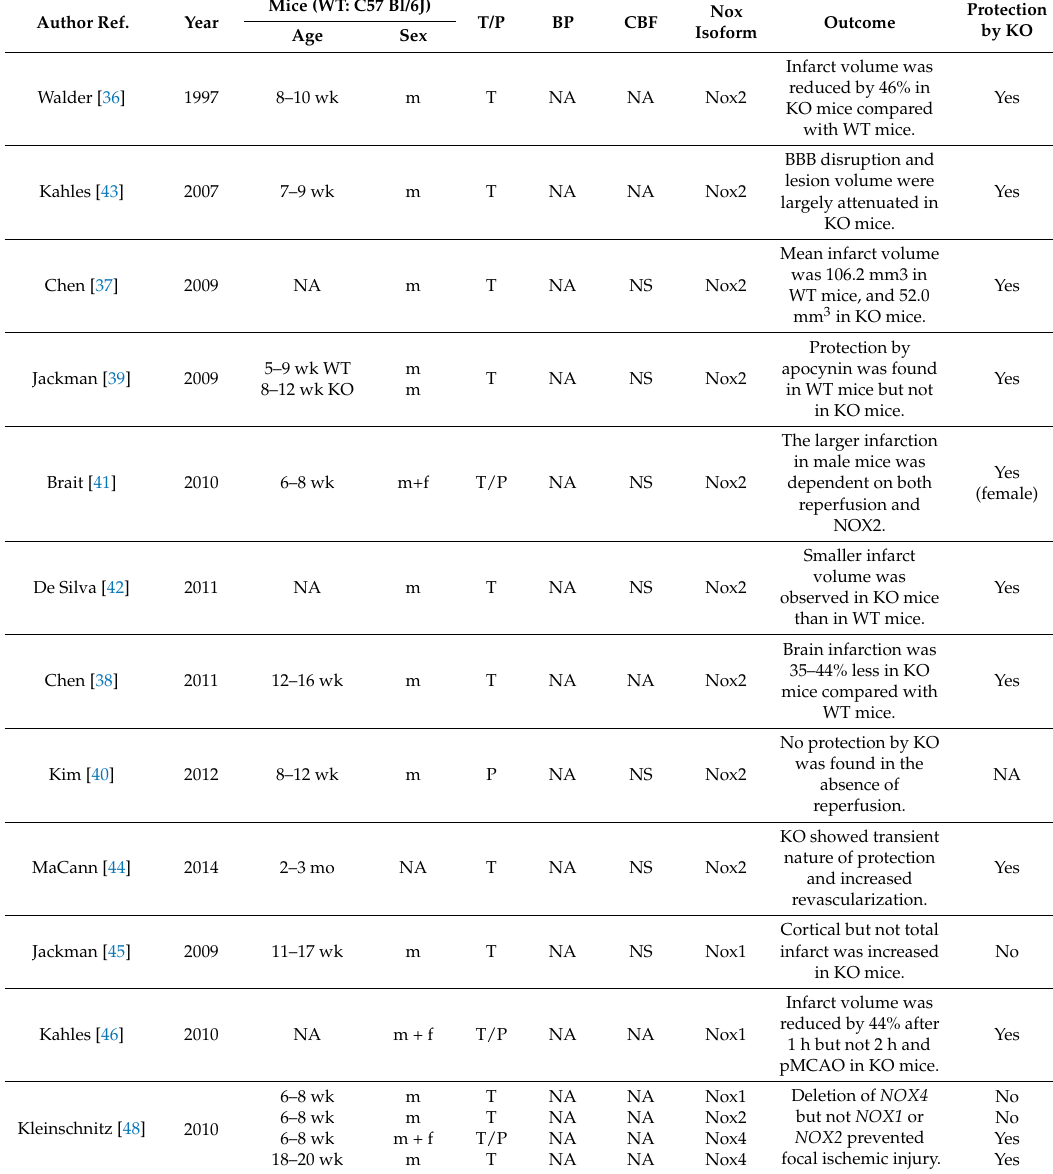
Table 2. Effects of Nox knock-outs on experimental